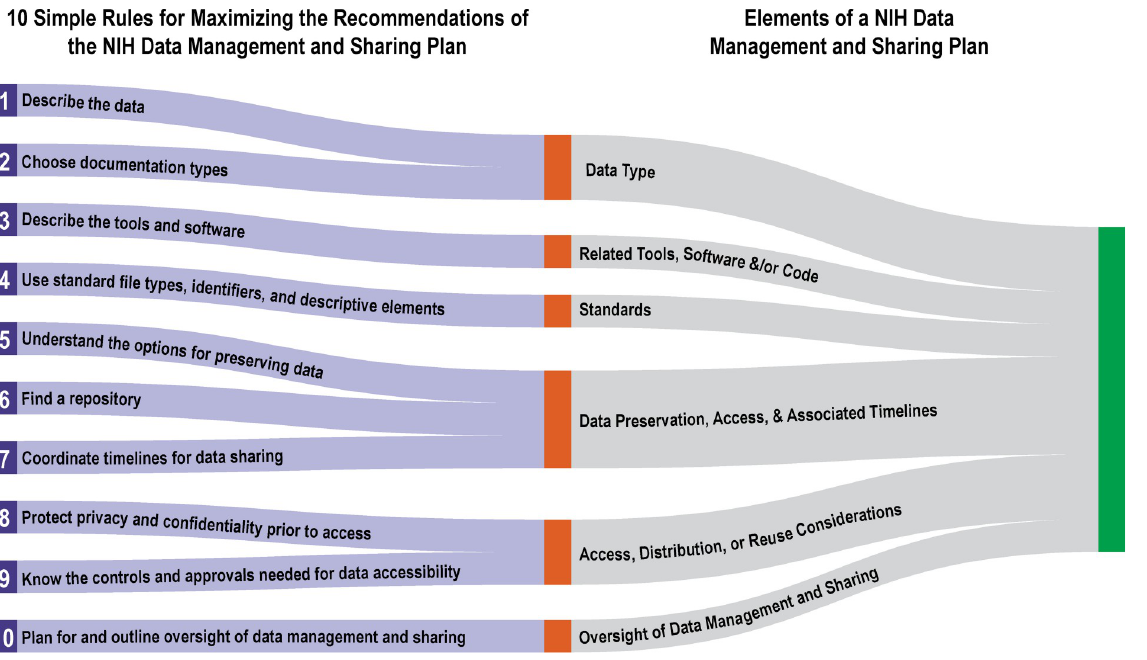
PLOS Computational Biology | https://doi.org/10.1371/journal.pcbi.1010397 August 3,